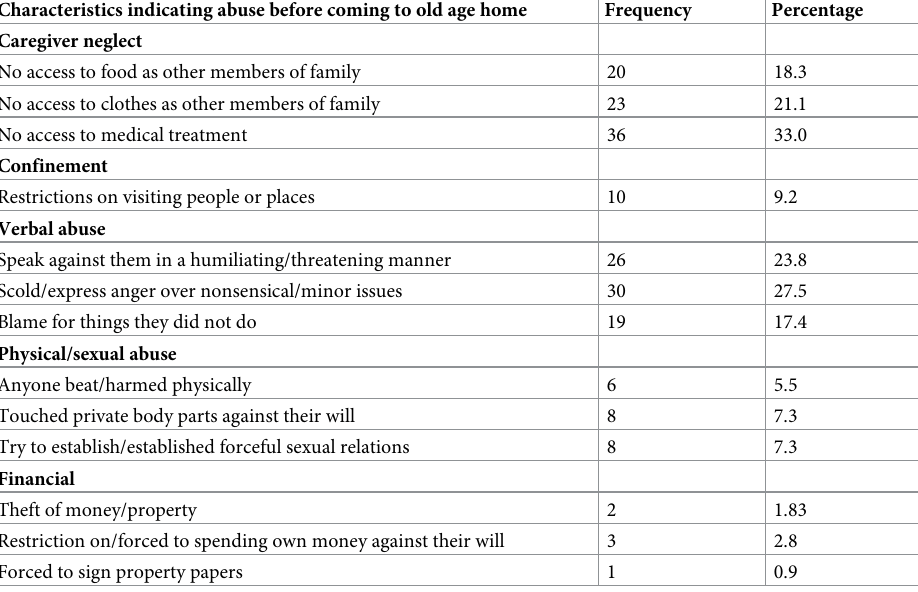
Table 4. Areas of abuse of older adults before coming to old age homes (n = 109).